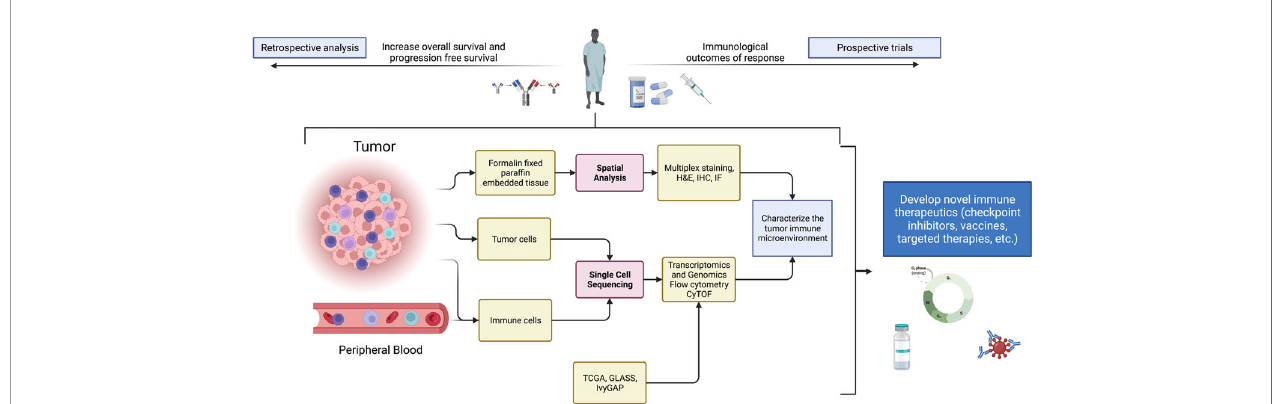
FIGURE 1 | Summary schematic detailing sources of samples, analytical techniques, and potential uses of data from single-cell technologies to improve and devise novel immune therapeutics. Speci fi cally, single-cell technologies can be implemented in clinical studies for biomarker discovery, characterization of novel drug targets, and the study of pharmacodynamic effects of therapies in window-of-opportunity clinical trials. Created